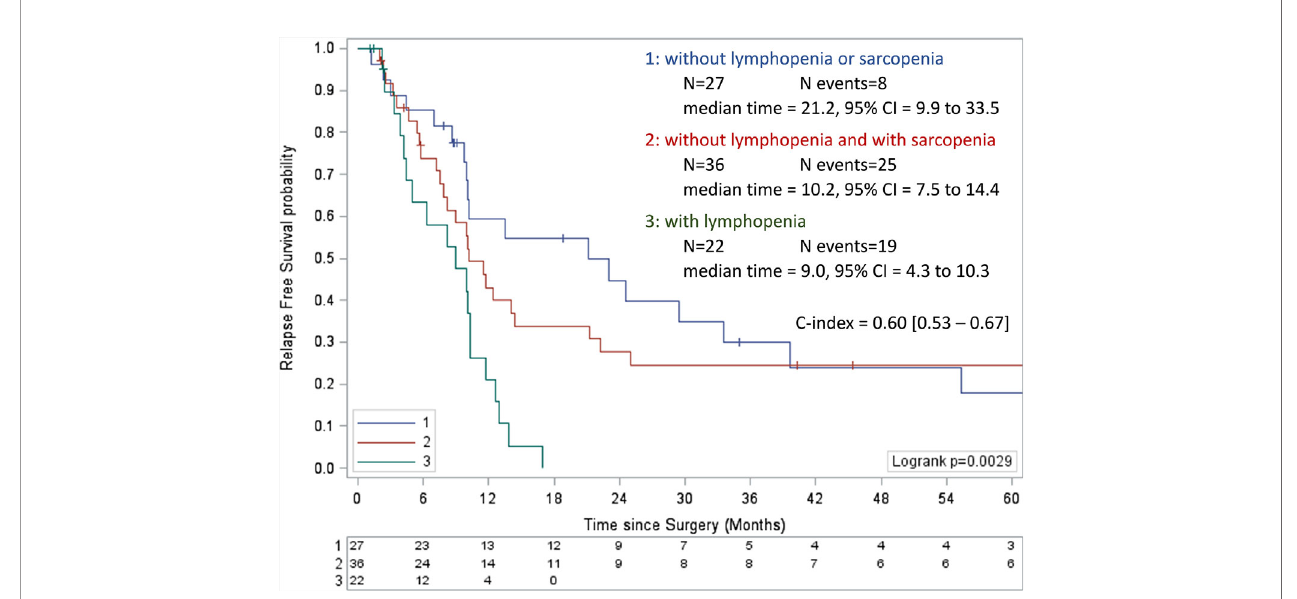
FIGURE 5 | Kaplan-Meier curves of relapse-free survival according to postoperative lymphopenia and sarcopenia. Values of the log-rank test P <0.05 were considered statistically signi fi cant, and all tests were two-sided. CI, con fi dence interval; NA, not